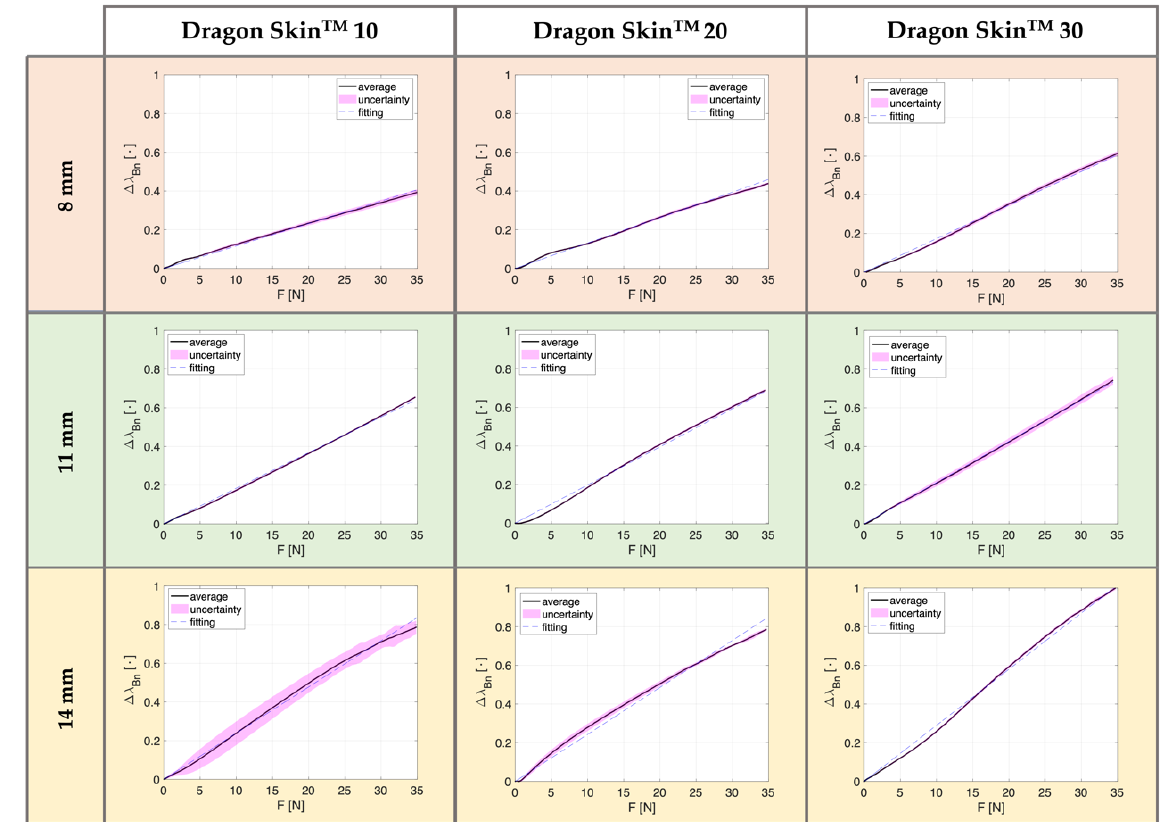
Figure 4. Normalized responses of the SSs (∆λ Bn vs. F) obtained in AT. The three columns distinguish the curves obtained according to the material used (i.e., Dragon Skin TM 10, 20, and 30), and the three rows marked with different colors refer to the thicknesses (8 mm in orange, 11 mm in green, and 14 mm in yellow). In each plot, the continuous black line represents the average ∆λ Bn vs. F, the highlighted area in magenta the related uncertainty, and the dotted blue line the linear fitting.